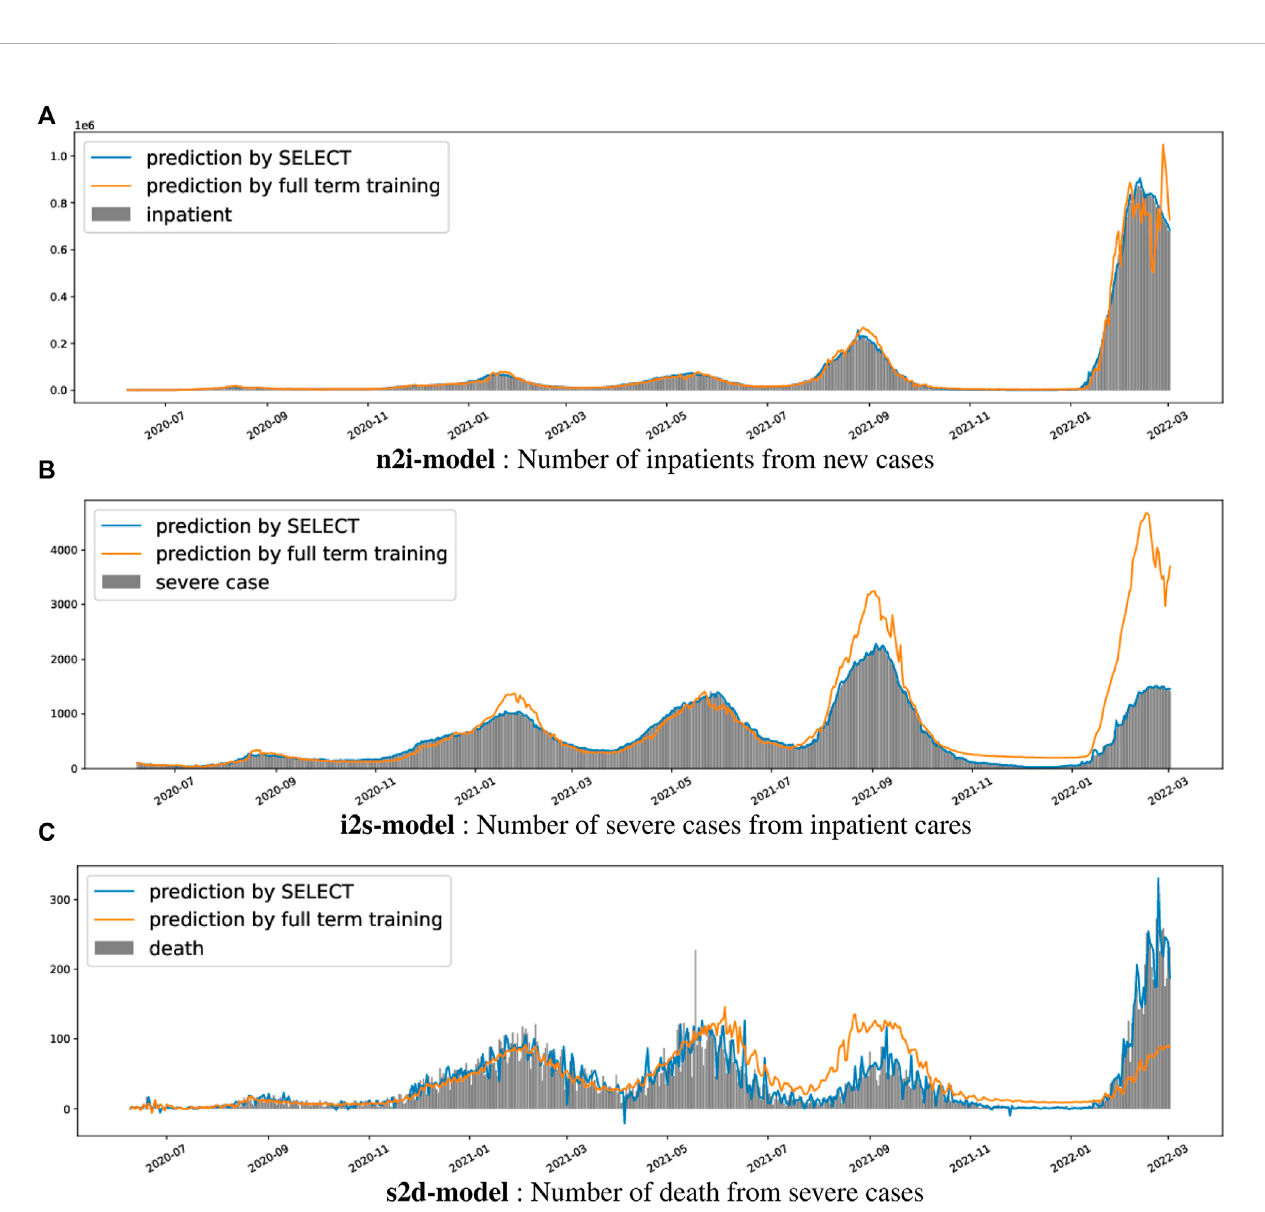
FIGURE 7 Predicted models of COVID-19. (A) n2i-model: Number of inpatients from new cases. (B) i2s-model: Number of severe cases from inpatient cares. (C) s2d-model: Number of death from severe cases.